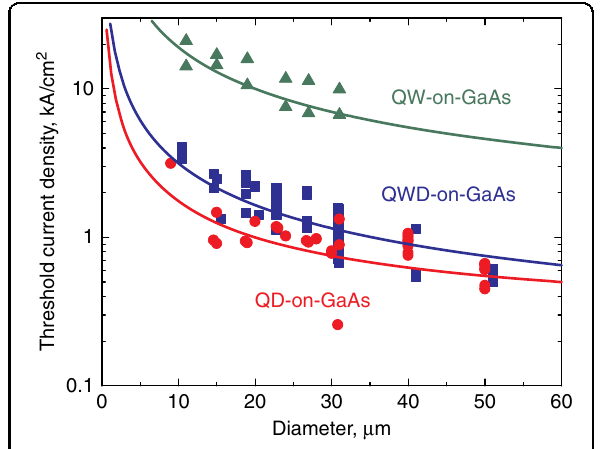
Fig. 11 Lasing threshold. Threshold current density of microdisk lasers of different types against disk diameter for different active regions. Solid lines are binomial approximations